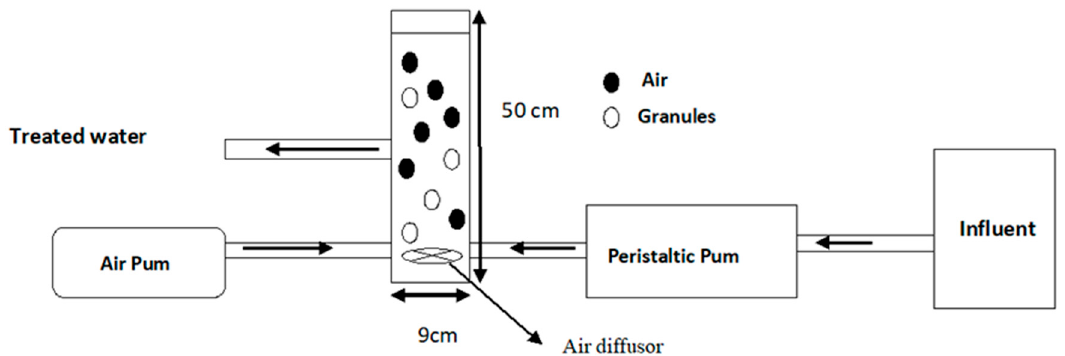
Figure 1. Schematic diagram of a sequencing batch bioreactor inoculated with cultures of denitrifying Pseudomonas strains. Two types of experiment were set up in the sequential batch bioreactors. For the first experiment, the different bacterial strains were tested for the formation of granules using sodium acetate as the only carbon source. For the second experiment, two carbon